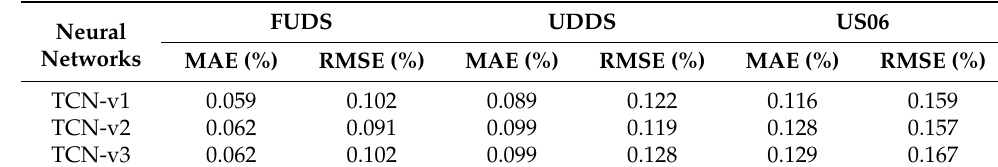
Table 2. The SOC estimation performance for ICR18650 under 25 ◦ C based on the three kinds of TCN